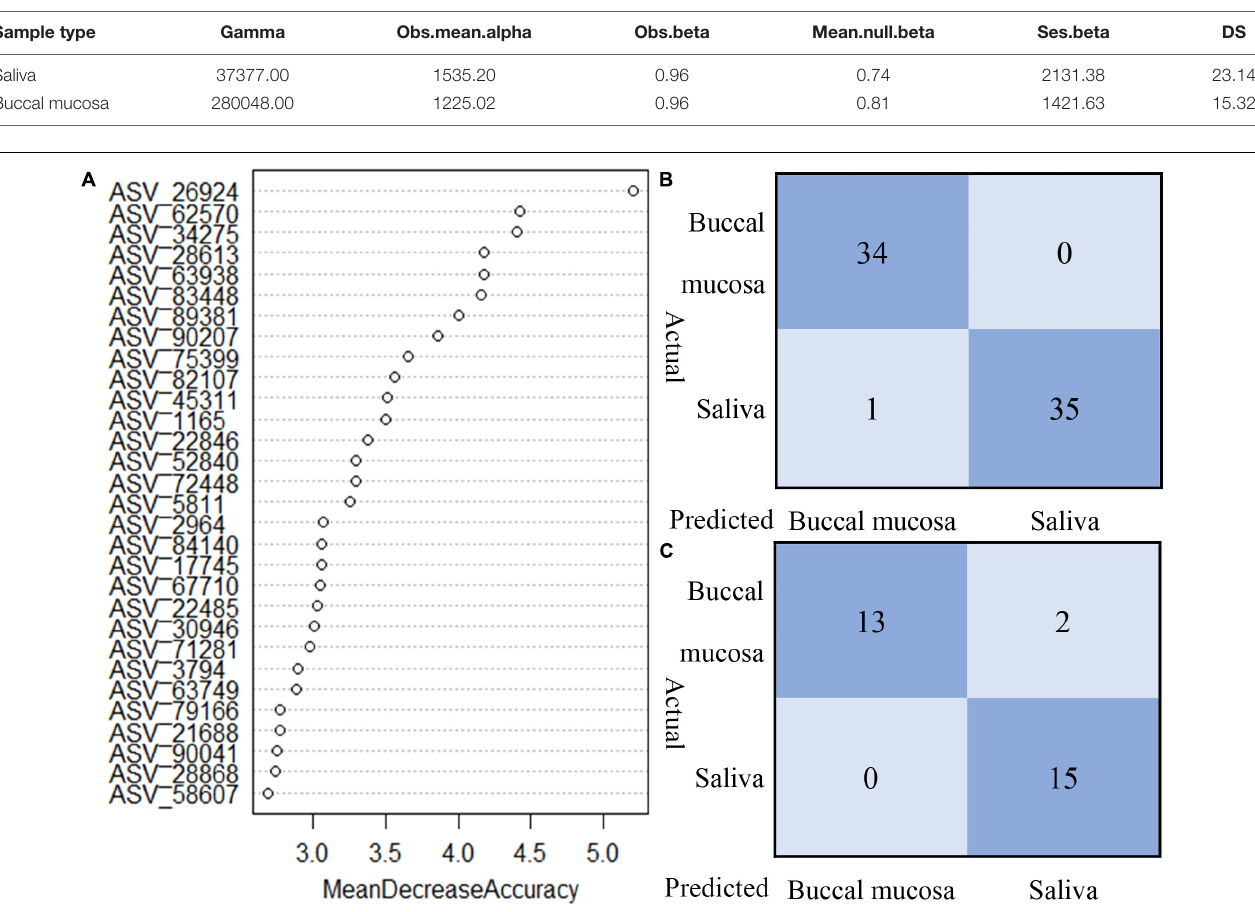
TABLE 2 | The diversity and deterministic strength (DS) of saliva and buccal mucosa that output from the null model.